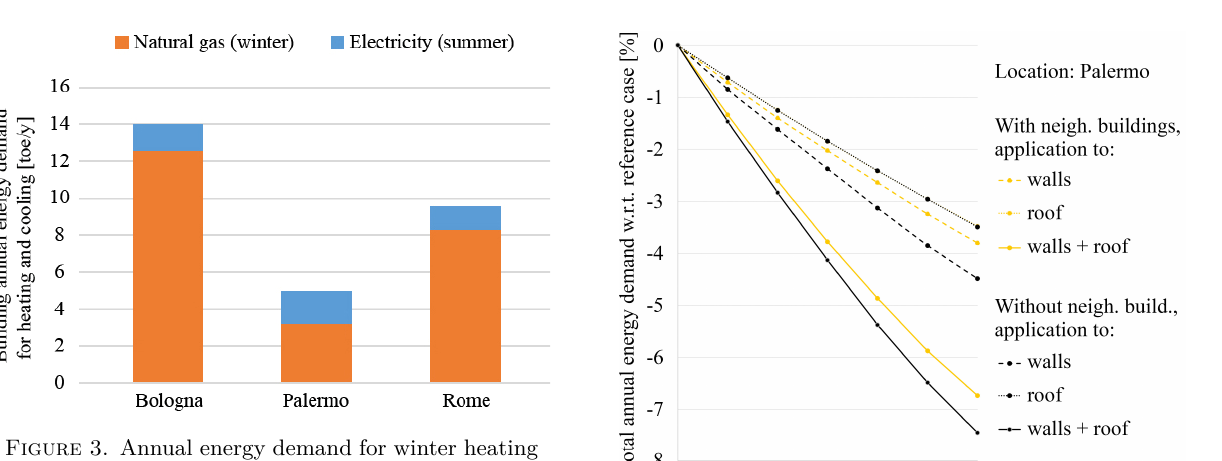
Figure 3. Annual energy demand for winter heating and summer cooling of the reference building, with- out "cool" cementitious tiles, for the three simulated locations.